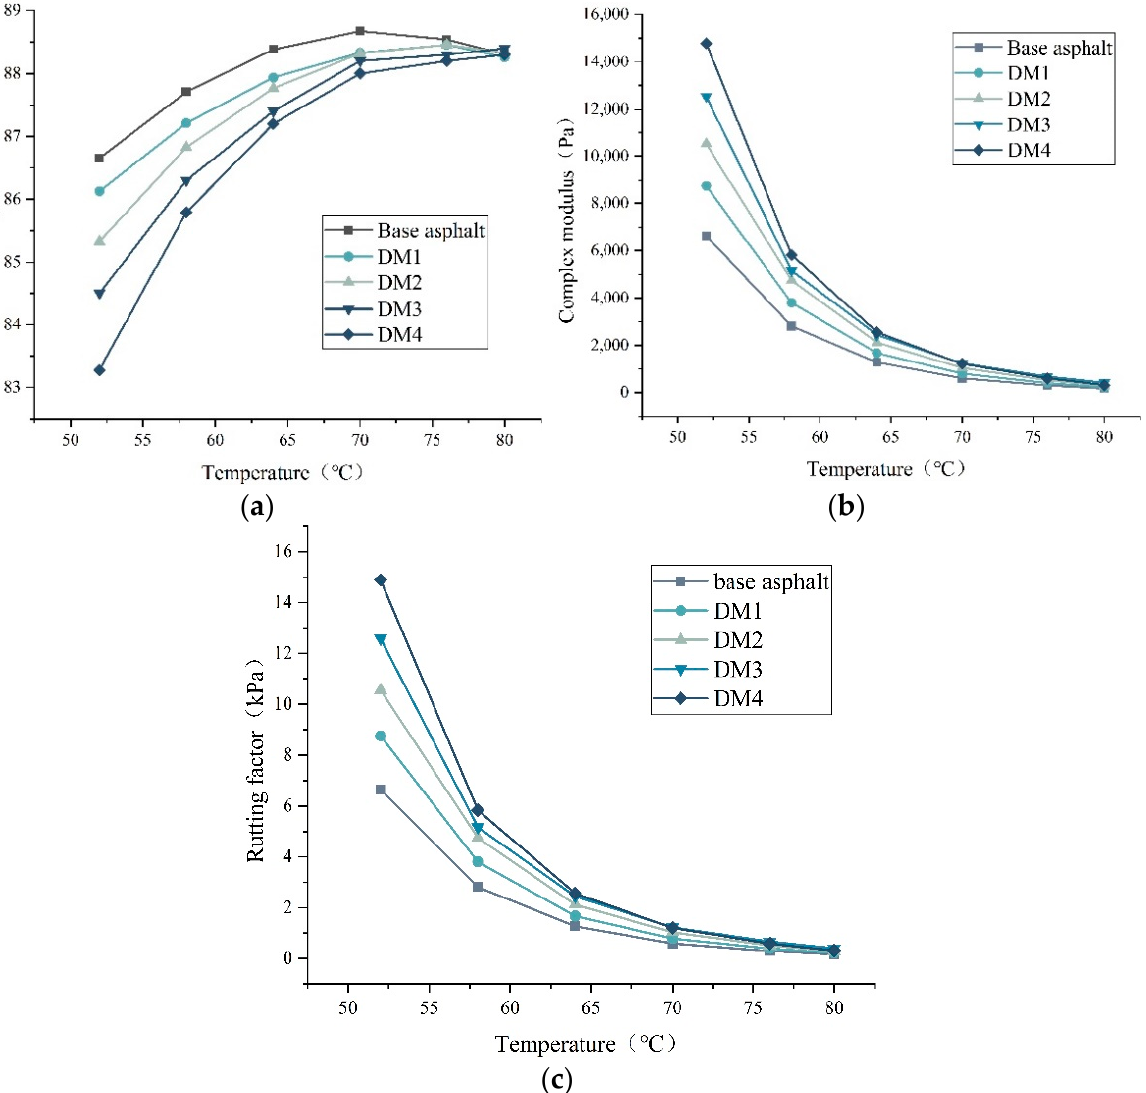
Figure 5. Temperature scanning test results. ( a ) Phase angle; ( b ) complex modulus; ( c ) rutting factor.